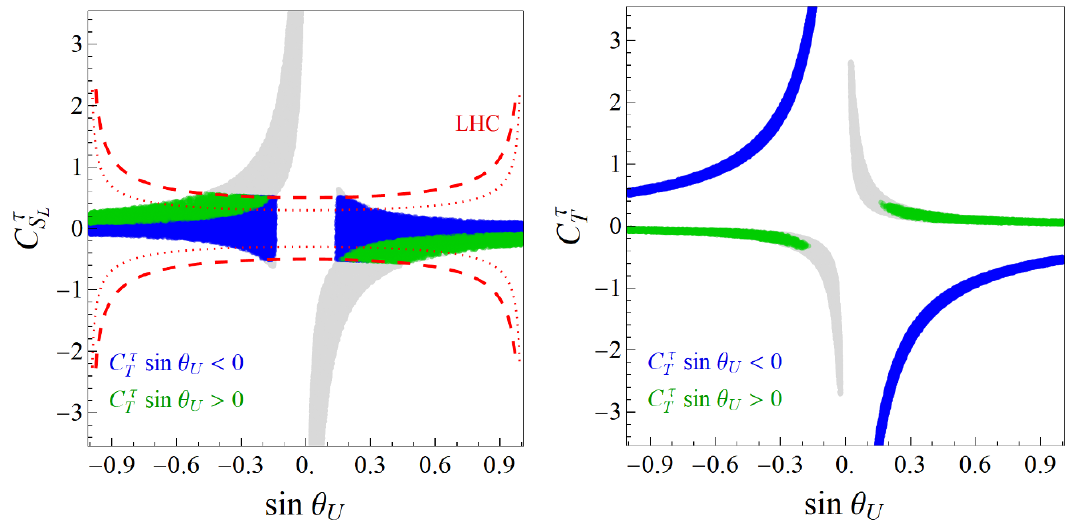
Figure 4 . sin (cid:18) U is plotted against C (cid:28) (left panel) and C (cid:28) (right panel) for the points allowed S L T by both ( g 2) (cid:22) and R to 1 (cid:27) accuracy. Gray points are excluded by the LHC results on the D ( (cid:3) ) (cid:0) strength signal (cid:22) (cid:28)(cid:28) [cf. eq. (3.25)], as illustrated by the red dotted (1 (cid:27) ) and dashed (2 (cid:27) ) lines on the left panel. The blue and green points are allowed by all observables for the two solutions found in (cid:12)gure 3, i.e. the one with C (cid:28) sin (cid:18) U < 0 (blue) and the one with C (cid:28) sin (cid:18) U > 0 (green). T T